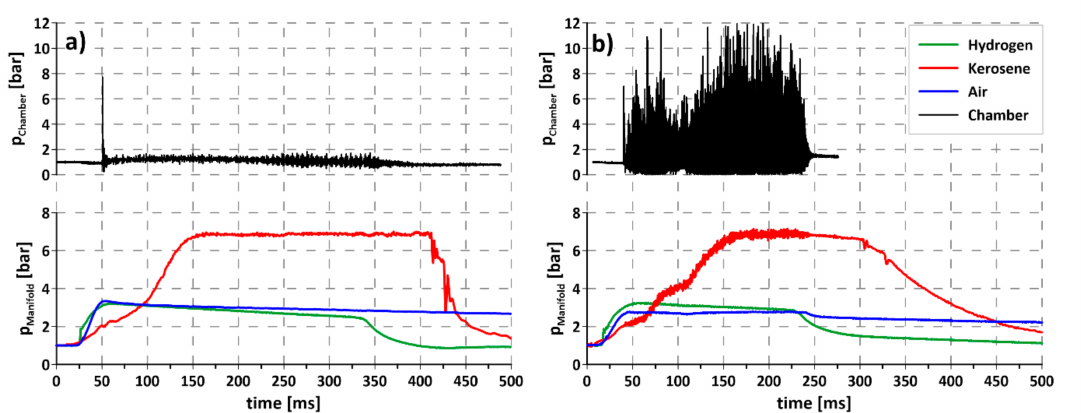
Figure 7. Propagation of rotating detonation for liquid kerosene–air mixture with hydrogen addition for di ff erent initial kerosene temperatures ( a ) room temperature (20 ◦ C), ( b ) elevated (100 ◦